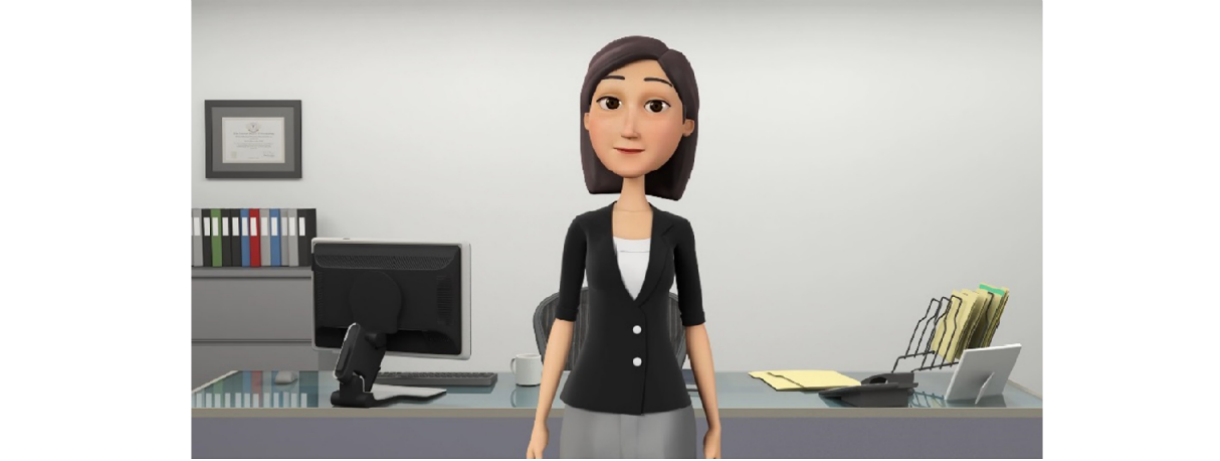
Figure 3. Image of Ashley, the relational agent in Diabetes Family Teamwork